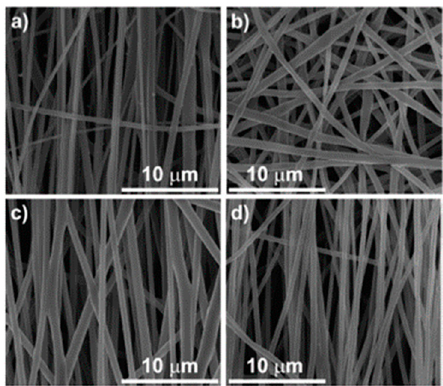
Figure 2. Morphology of aligned PLA fibres: ( a ) non-sterilized, ( b ) sterilized by ethylene oxide, ( c ) sterilized by UV radiation, ( d ) sterilized by gamma-rays radiation. Reprinted with permission from T.A.M. Valente, D.M. Silva, P.S. Gomes et al., ACS Appl. Mater. Interfaces., 2016, 8, 3241–3249 [35]. Copyright 2016 American Chemical Society.